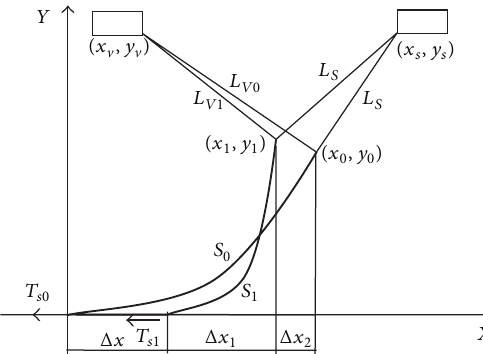
Figure 6: Forces on a large deformation beam segment 𝛿𝑠